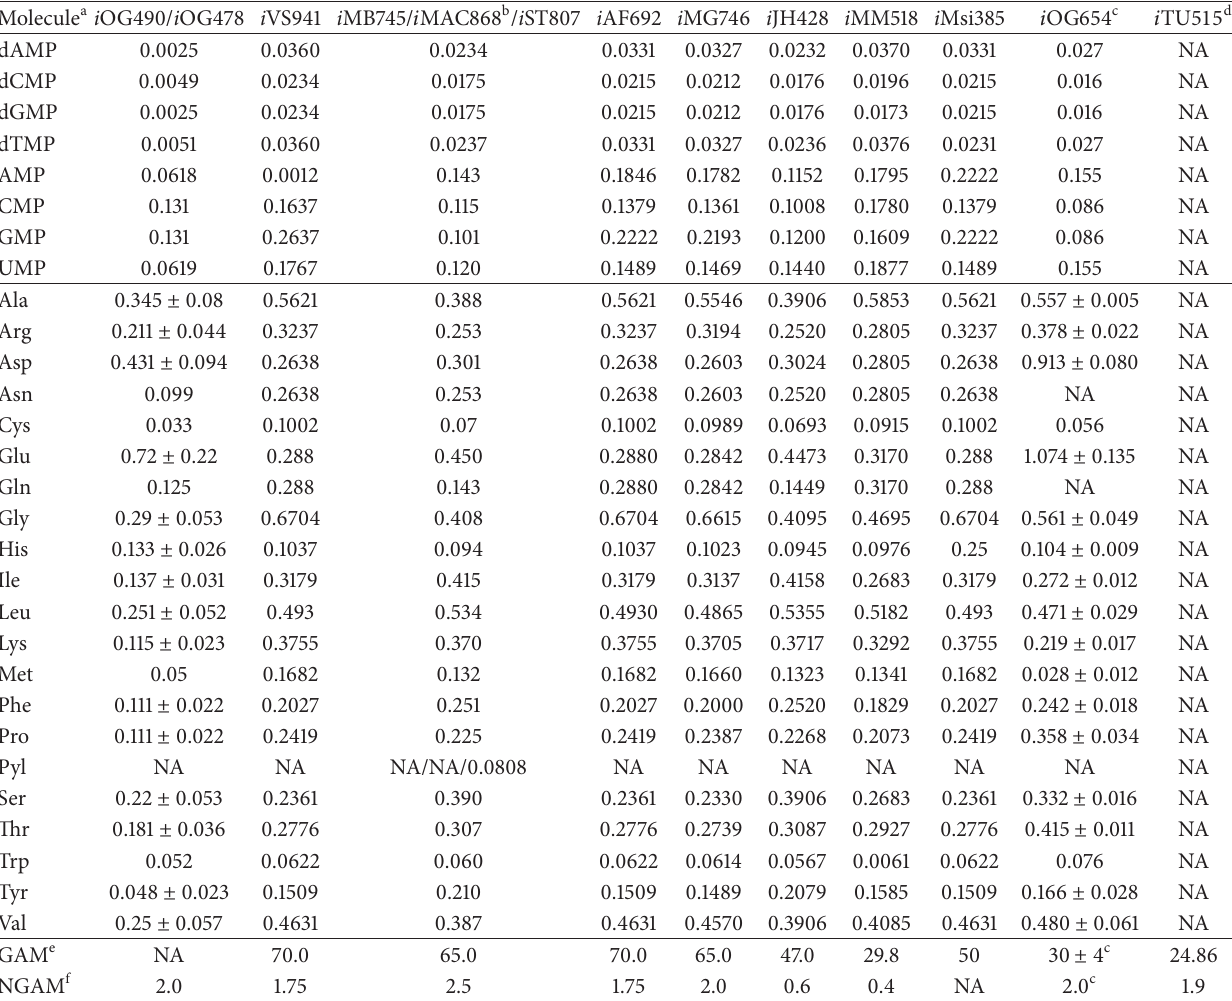
Table 3: Biomass Compositions and Energy Requirements . Molar composition of each Archaea’s biomass for nuclei and amino acids. Additionally, energy requirements for growth and